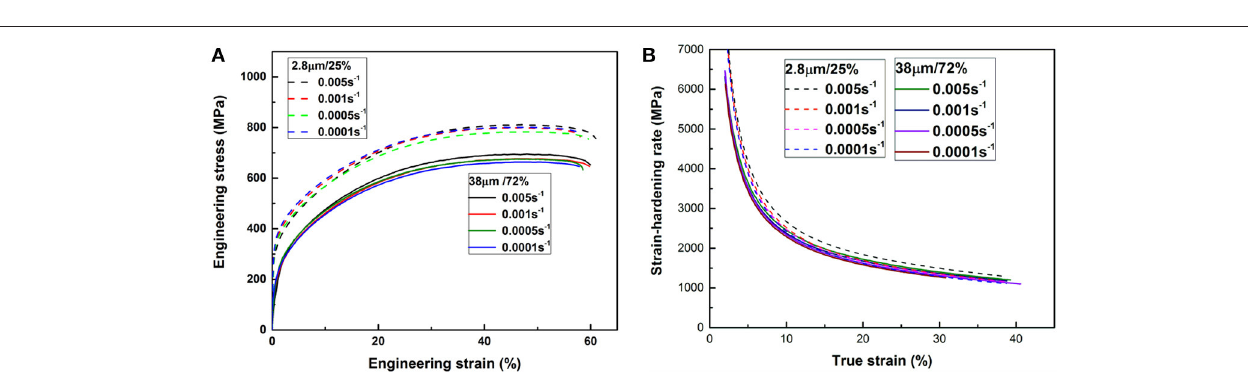
FIGURE 3 | (A) Typical tensile stress-strain curves of the DP-HEAs with varying FCC grain sizes and initially available HCP phase fractions. (B) Strain hardening curves with respect to true strain corresponding to the stress-strain curves shown in (A)